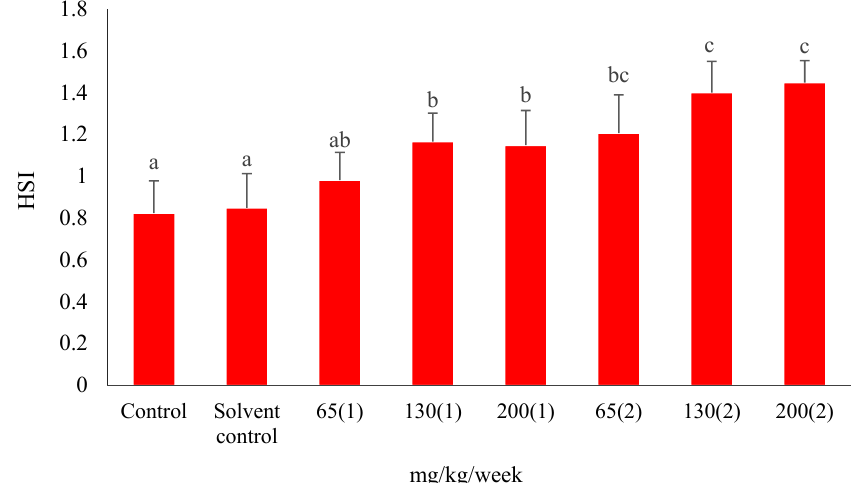
Fig. 4: Mean hepatosomatic index (HSI, mean ± standard error) of the Caspian kutum after 7 (1) and 14 (2) days of exposure to fipronil